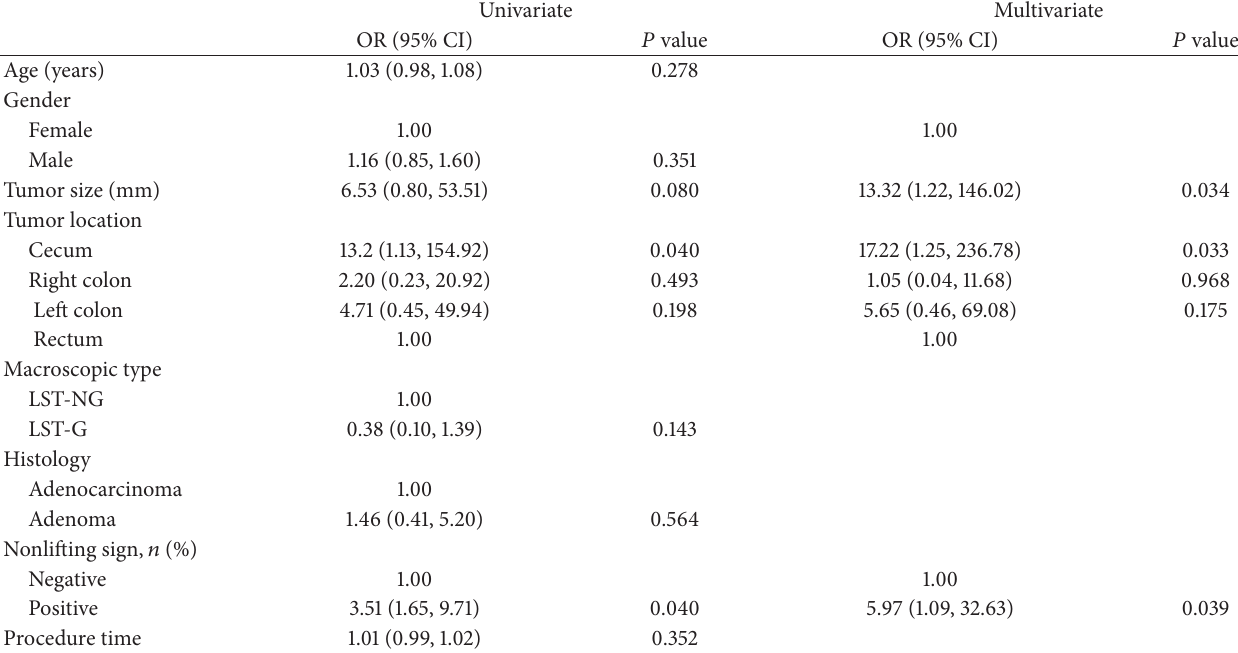
Table 2: Univariate and multivariate analyses of factors affecting perforation in ESD ( 𝑛 = 92 ).